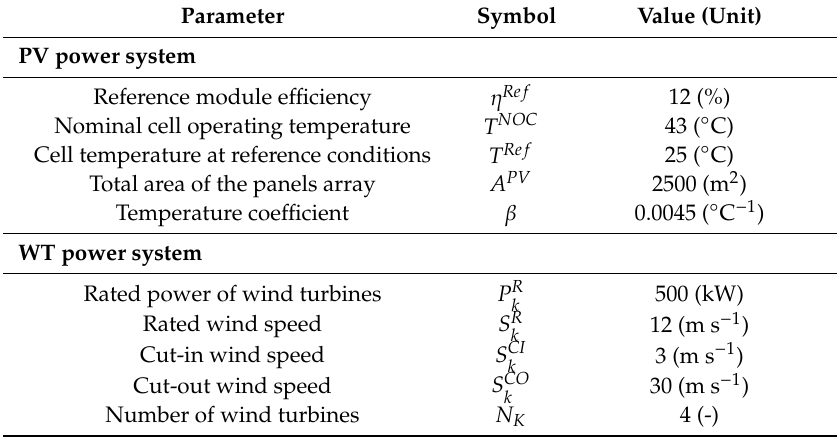
Figure 4. Wind speed data for the case studies. Table 1. Modelling parameters for the renewable energy generation units